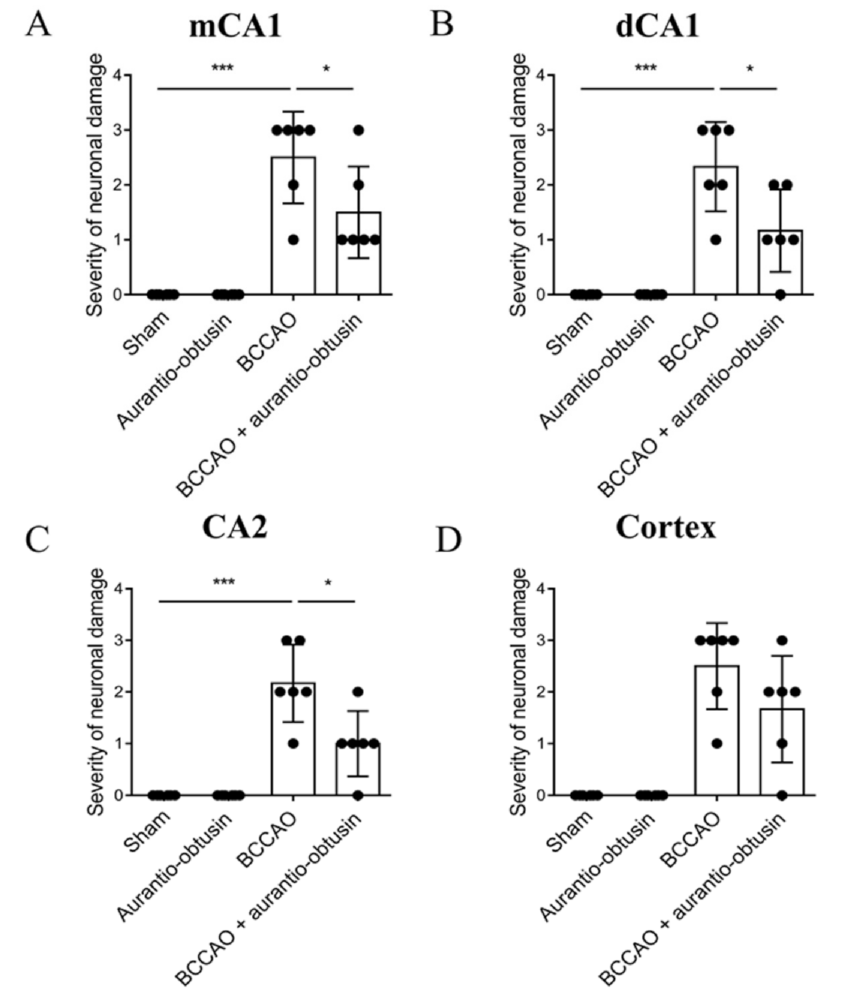
Figure 6. Effect of aurantio-obtusin on transient forebrain ischemia-induced neuronal damage. ( A − D ). Severity of neuronal damage in mCA1 ( A ), dCA1 ( B ), CA2 ( C ), and cortex ( D ) regions. The cells were counted in six sections by every eight sections interval (total 48 sections) per animal by a person blind to the treatment group, and the average cell count per section was computed. The degree of damage by the Nissl staining after ischemia was semiquantitatively scored from 0 to 3. Neurons showing whole neuronal body shape were determined as healthy neurons. The percentage of healthy neurons compared to sham group was used as quantification criteria. (0, same to shame group; 1, >70% of sham group; 2, 40–70% of sham group; 3, 0–40% of sham group). Data represented as mean ± SD with raw data. * p < 0.05, *** p <